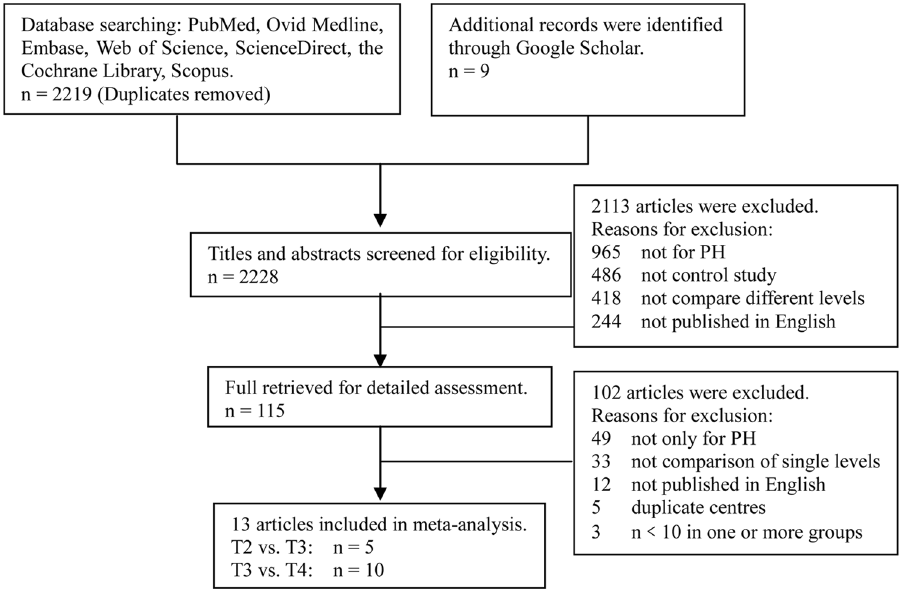
Figure 1. Flow diagram of screened and included